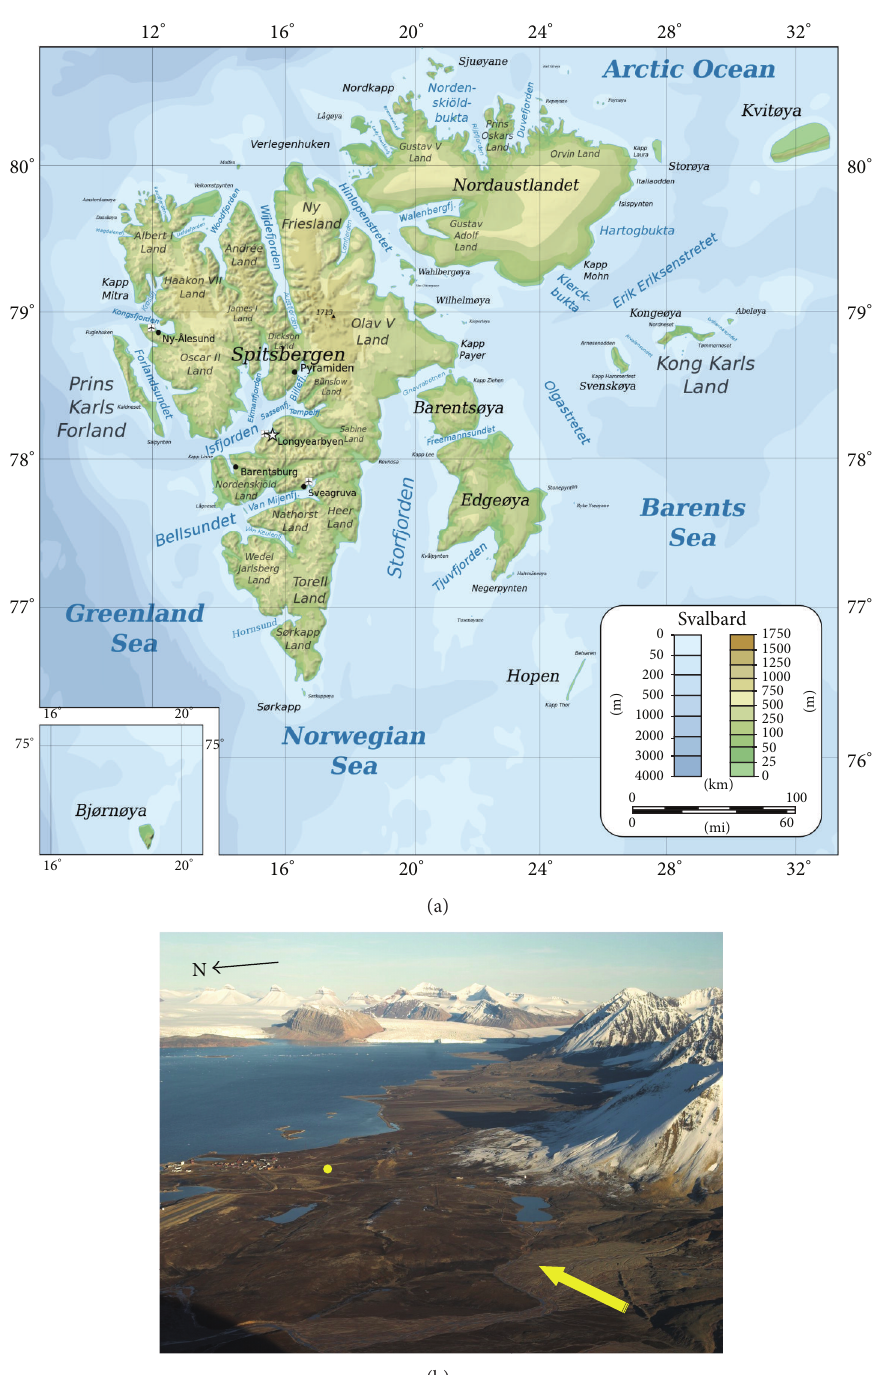
Figure 1: (a) Map of Svalbard (http://commons.wikimedia.org/wiki/File:Topographic map of Svalbard.svg#), (b) Kongsjord region with Ny- ˚Alesund[42].Additionallymarkedaretheeddycovariancesite(yellowdot)andthemainoutflowdirectionoftheBroggerbreenglacier(yellow